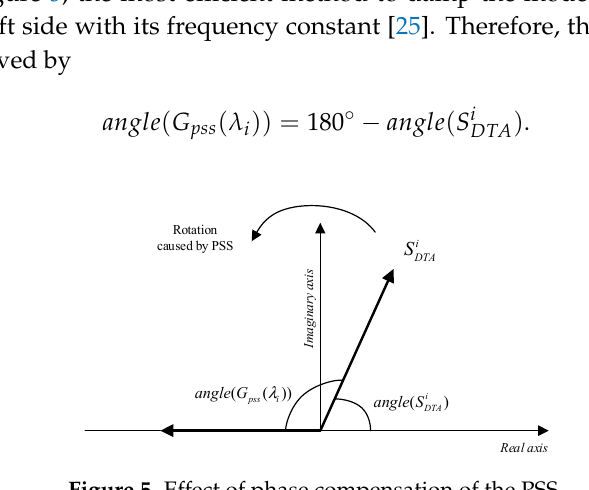
Figure 5. Effect of phase compensation of the